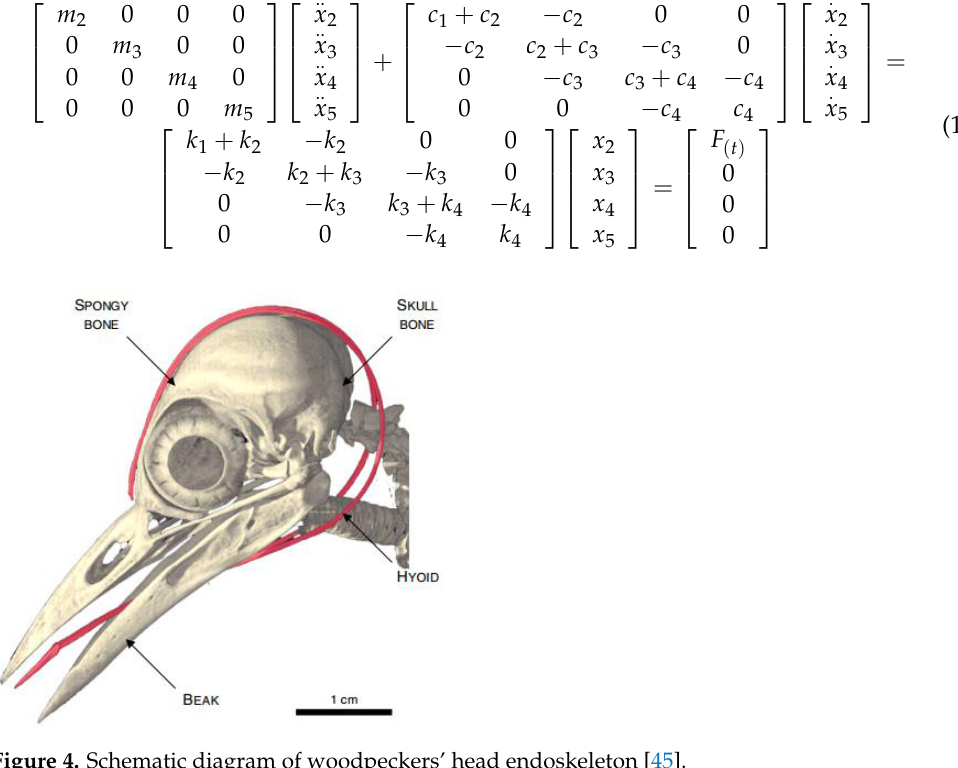
Figure 4. Schematic diagram of woodpeckers’ head endoskeleton [45].